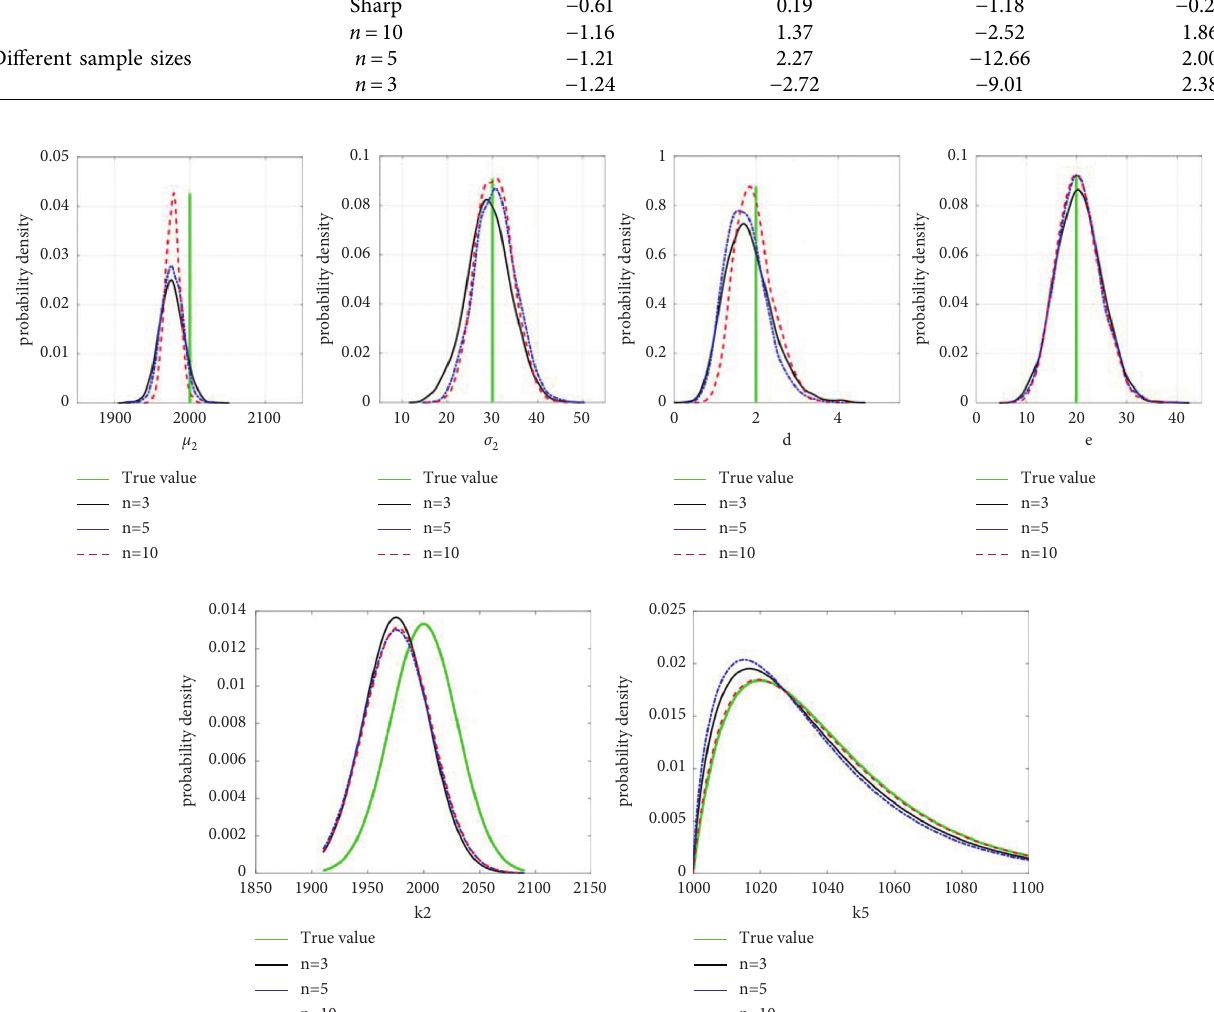
Figure 12: Influence comparison of experimental data amount on identification of aleatory uncertain parameter. plotted with grey lines in Figure 15. According to the Figure 13. In this case study, the aleatory and epistemic , k , c 􏼈 􏼉 and α � a, b { } , posterior mean of the hyperparameter, the optimal PDFs of uncertain parameter sets are θ � k 2 5 spring stiffness are obtained as plotted with black lines to respectively, while hyperparameter set is � μ , σ , d, e, μ , σ 􏼈 􏼉 . compare with true distribution plotted with green dotted α c c 2 2 2 lines in Figure 15. Furthermore, the expectation and 95% confidence interval (CI) for k be gained from the corresponding optimal PDF. The optimal citation magnitude are plotted with red solid and blue dashed lines, respectively, in Figure 15.